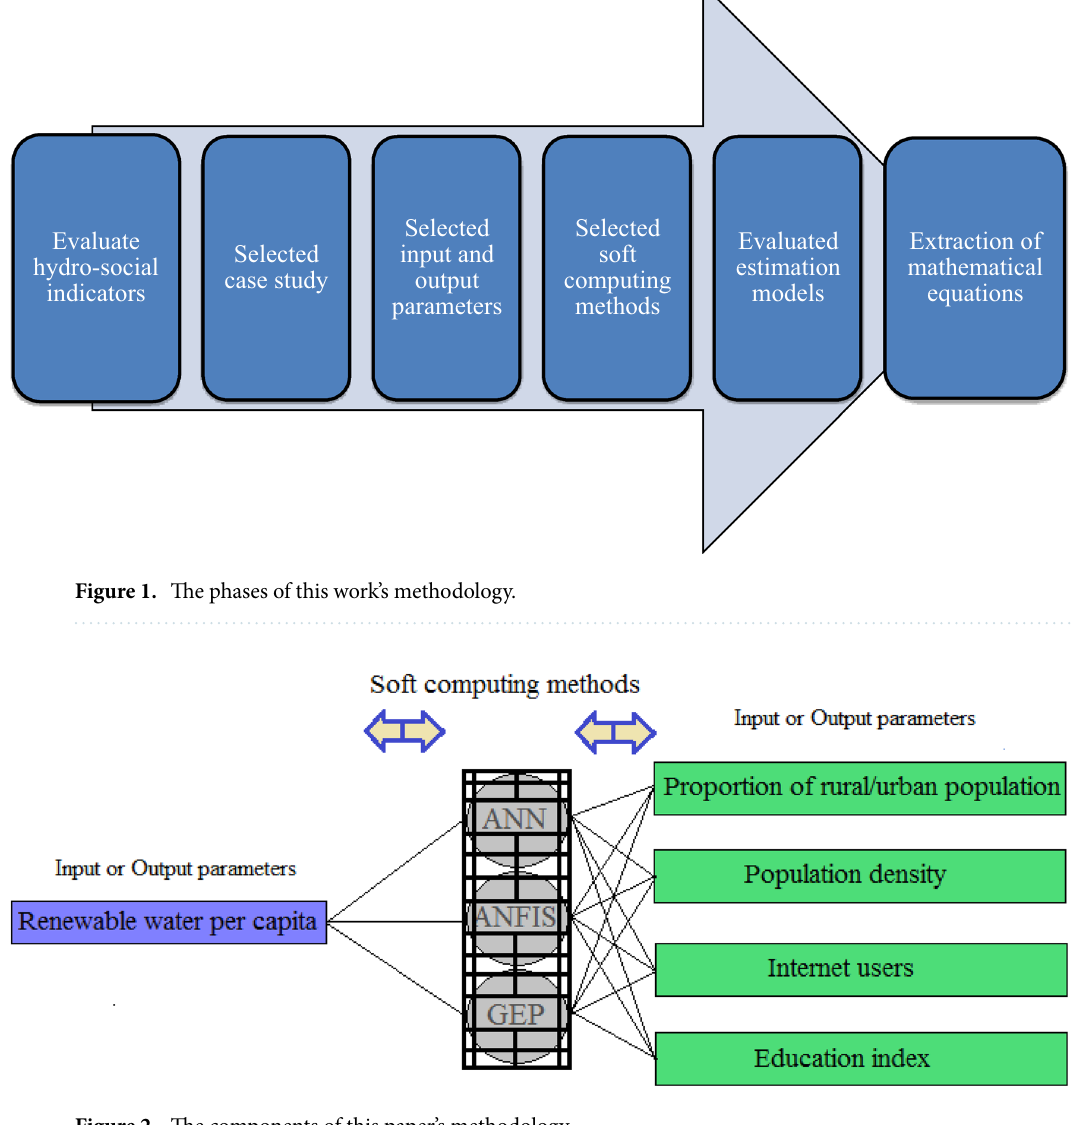
Figure 2. The components of this paper’s